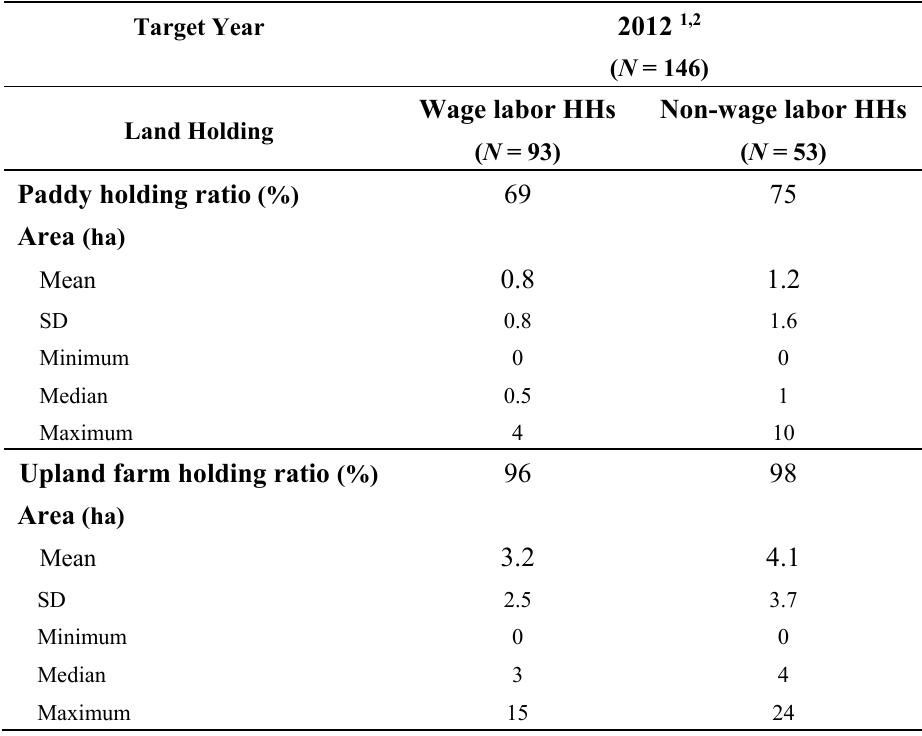
Table 2. Holding ratios and areas of farming fields of HHs engaged and not engaged in wage labor in